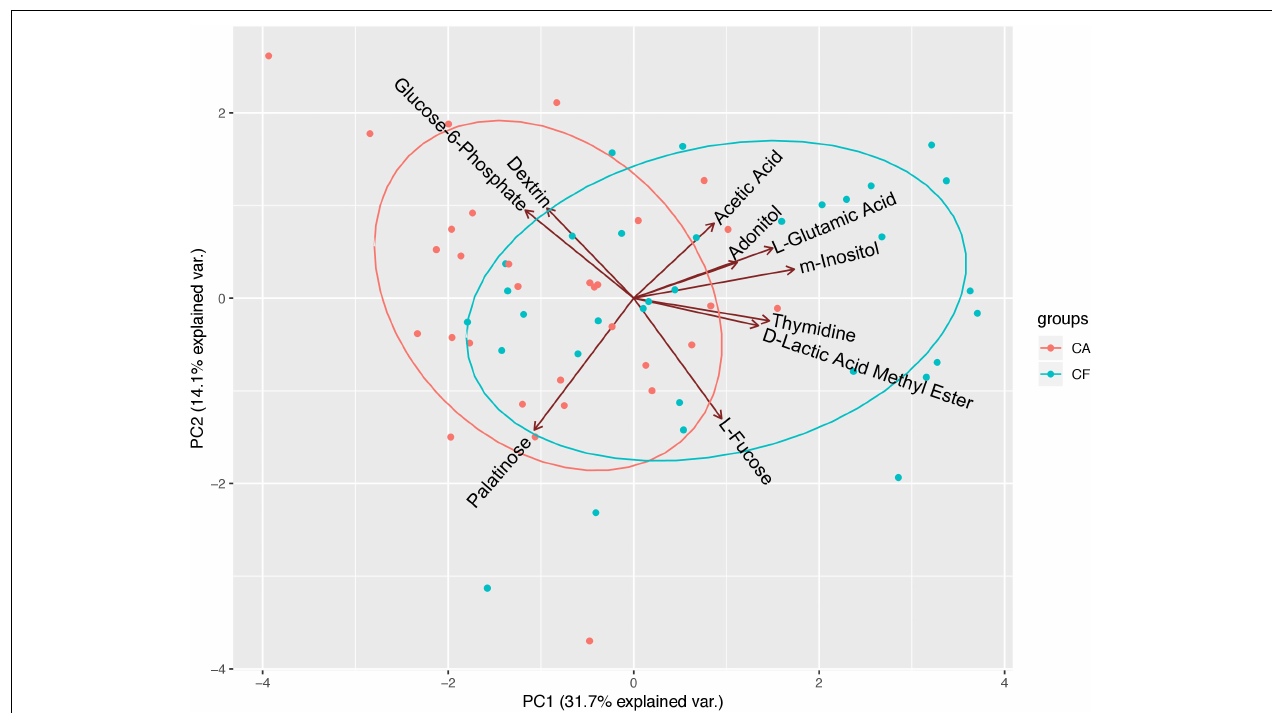
FIGURE 5 | Principal component analyses (PCAs) of microbial community’s utilization patterns in CF and CA groups. The 10 significantly differentially catabolized carbon sources between the CF and CA groups at 24 h were analyzed using transformed data by PCAs. PC1 and PC2 accounted for 31.7 and 14.1% of the total variance. The green dots represent samples from CF group and red dots represent samples from CA group. The green ellipse and red ellipse represent 95% confident interval of CF and CA group, respectively.